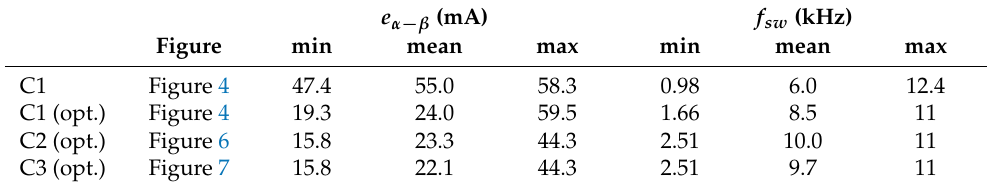
Figure 6. Performance map for the C2 controller, e α − β and each operating point, with an optimal value for λ sc ( a ) and values of λ sc ( b ). Table 3. Summary of Results for Comparison with Previous